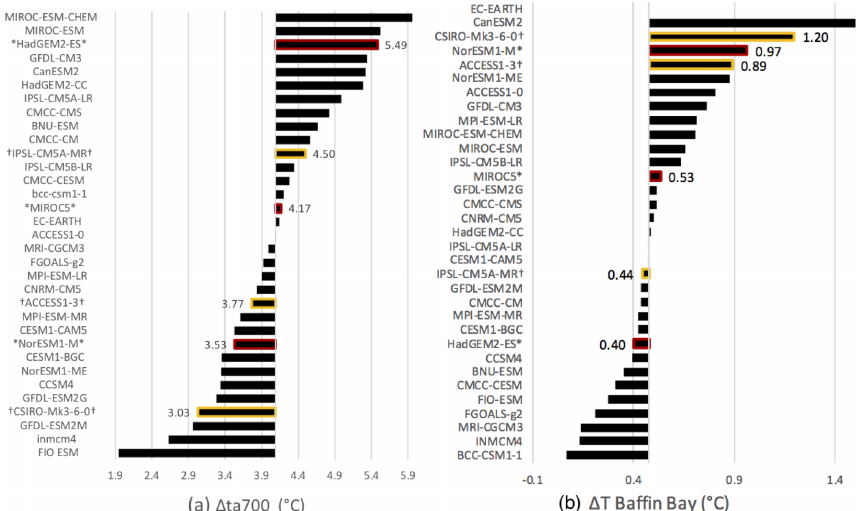
Figure 6. Projected RCP8.5 warming for each CMIP5 model over Greenland. (a) Change in 700hPa air temperature over the Southern Ocean between 1980–2000 and 2080–2100. (b) Change in ocean temperature in the Baffin Bay region between 1980–2000 and 2080–2100. Models selected in the top three (top six) ensemble are highlighted in red